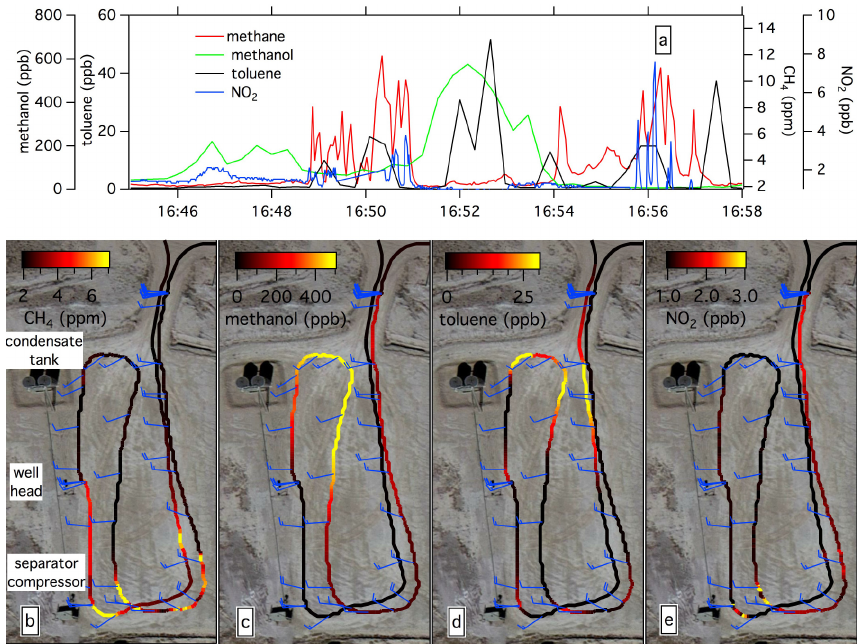
Figure 5. The drive track close to a gas well color coded by measured methane (b) , methanol (c) , toluene (d) and NO 2 (e) . The wind barbs indicate the prevailing wind direction coming from left to right in the image. The time series for this period is shown in (a)